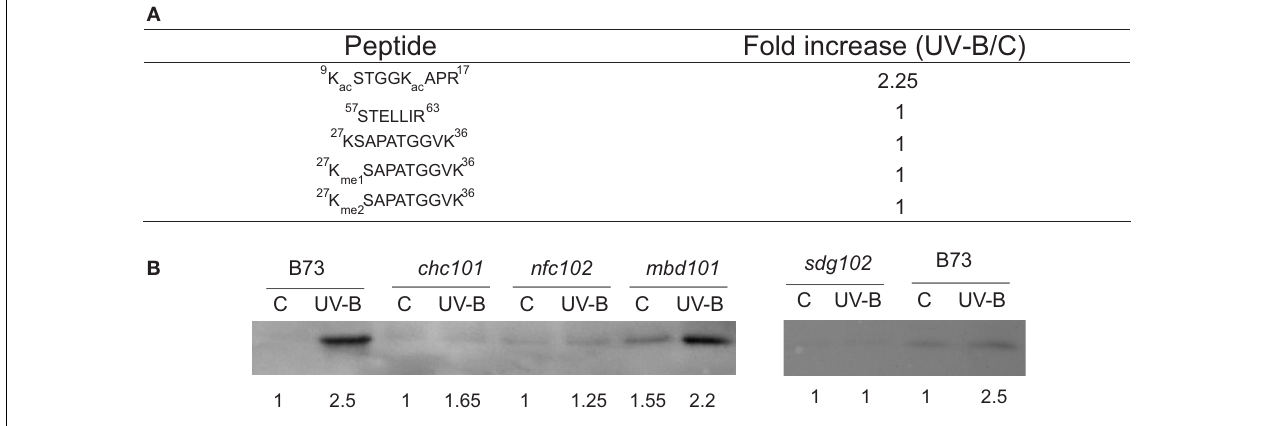
FIGURE 1 |Analysis of histone H3 modifications in maize after a UV-B treatment. (A) Average ratios of peak areas integrated from LC-MS runs of representative peptides detected from the duplicates of UV-B-treated and the control in the absence of UV-B histone H3.The peptide 9-KacSTGGKacAPR-17 is more abundant in the UV-B-exposed sample, while non-covalent modified